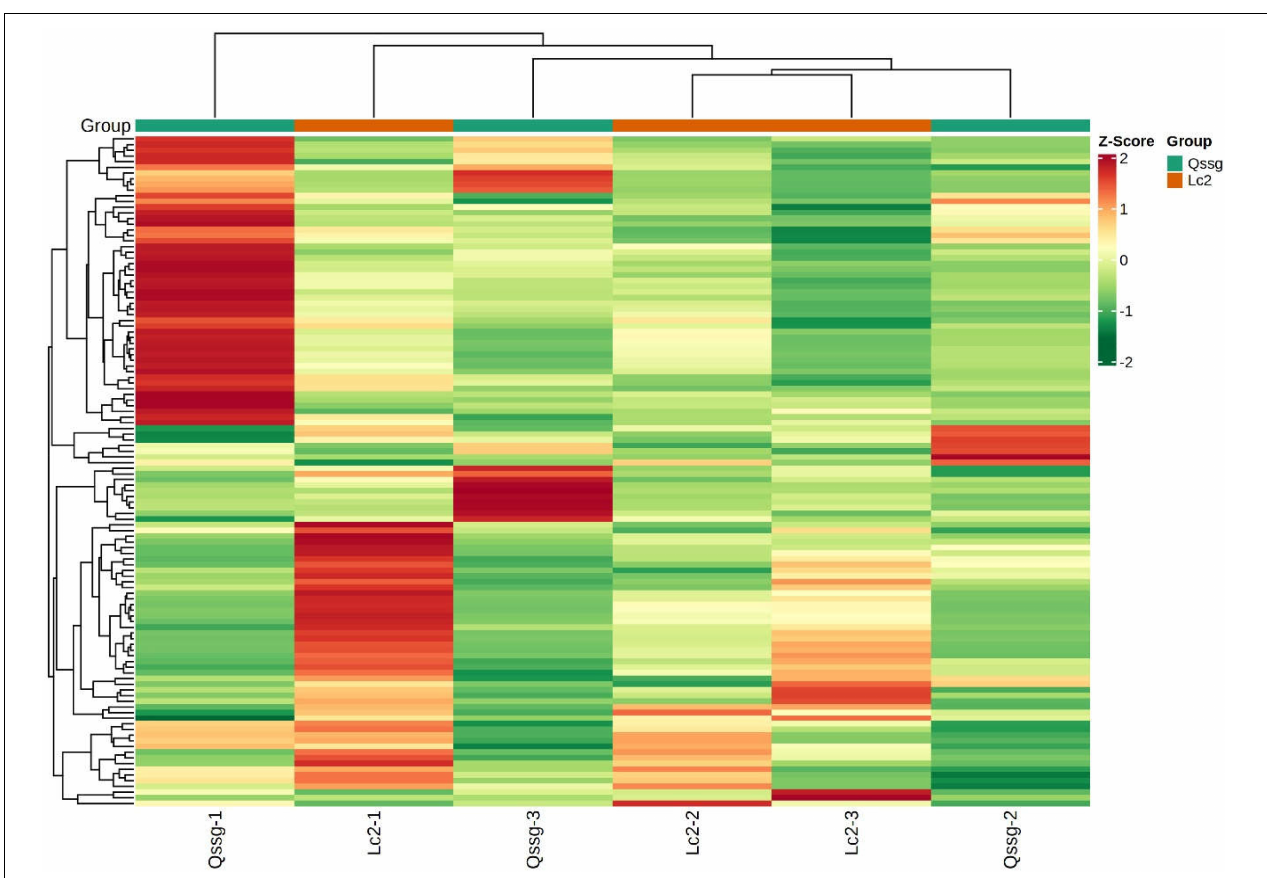
FIGURE 6 | Clustering heat map of flavonoids with significant difference between Qssg and Lc